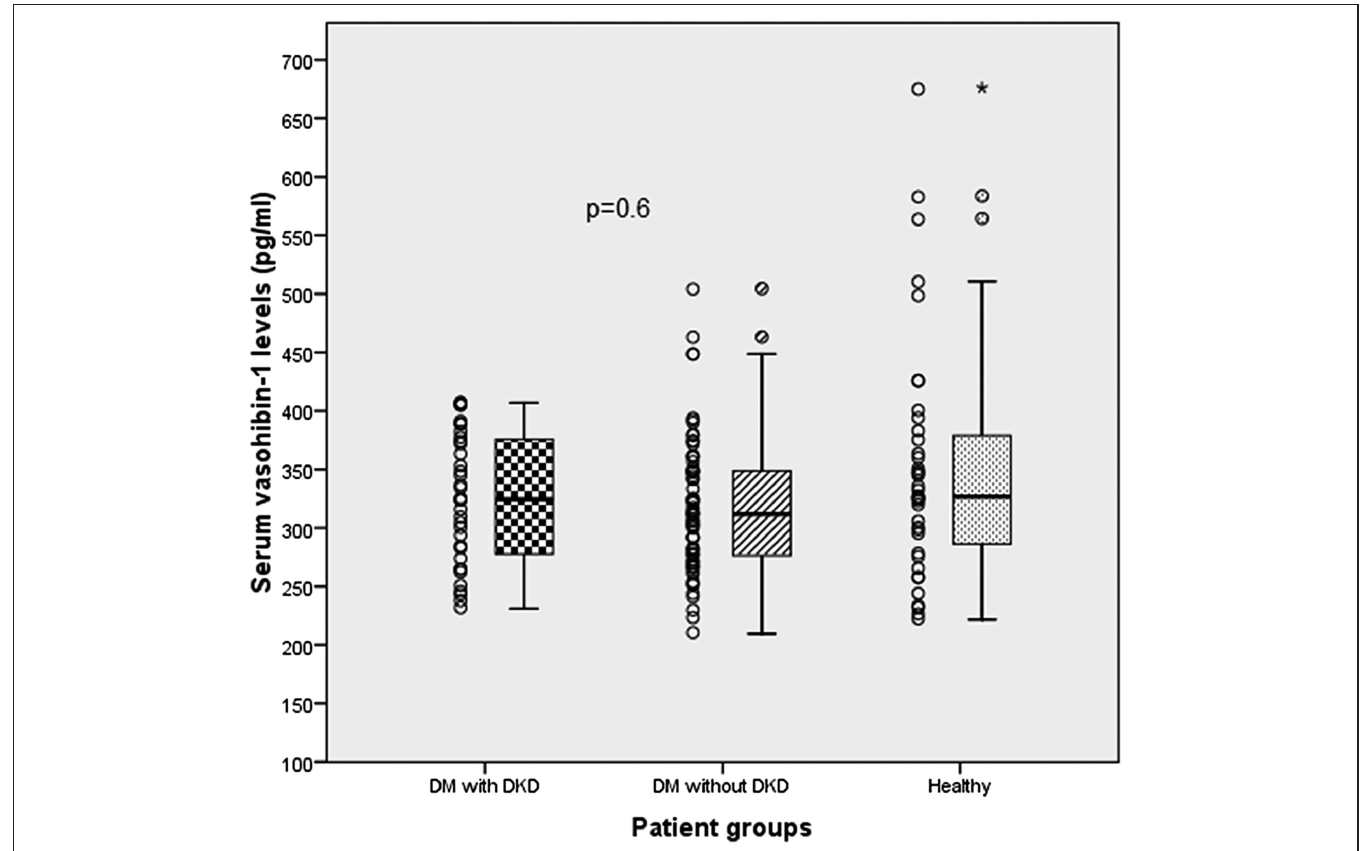
Figure 1. Dot-plot and box-plot graphics of serum vasohibin-1 levels of patients